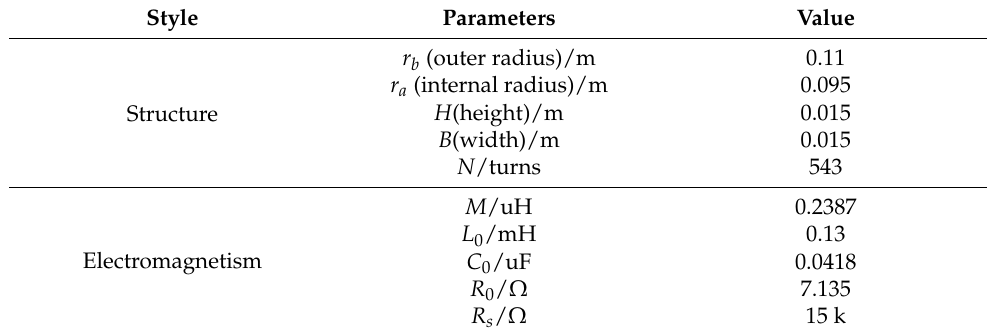
Table 4. Main parameters of the Rogowski coil